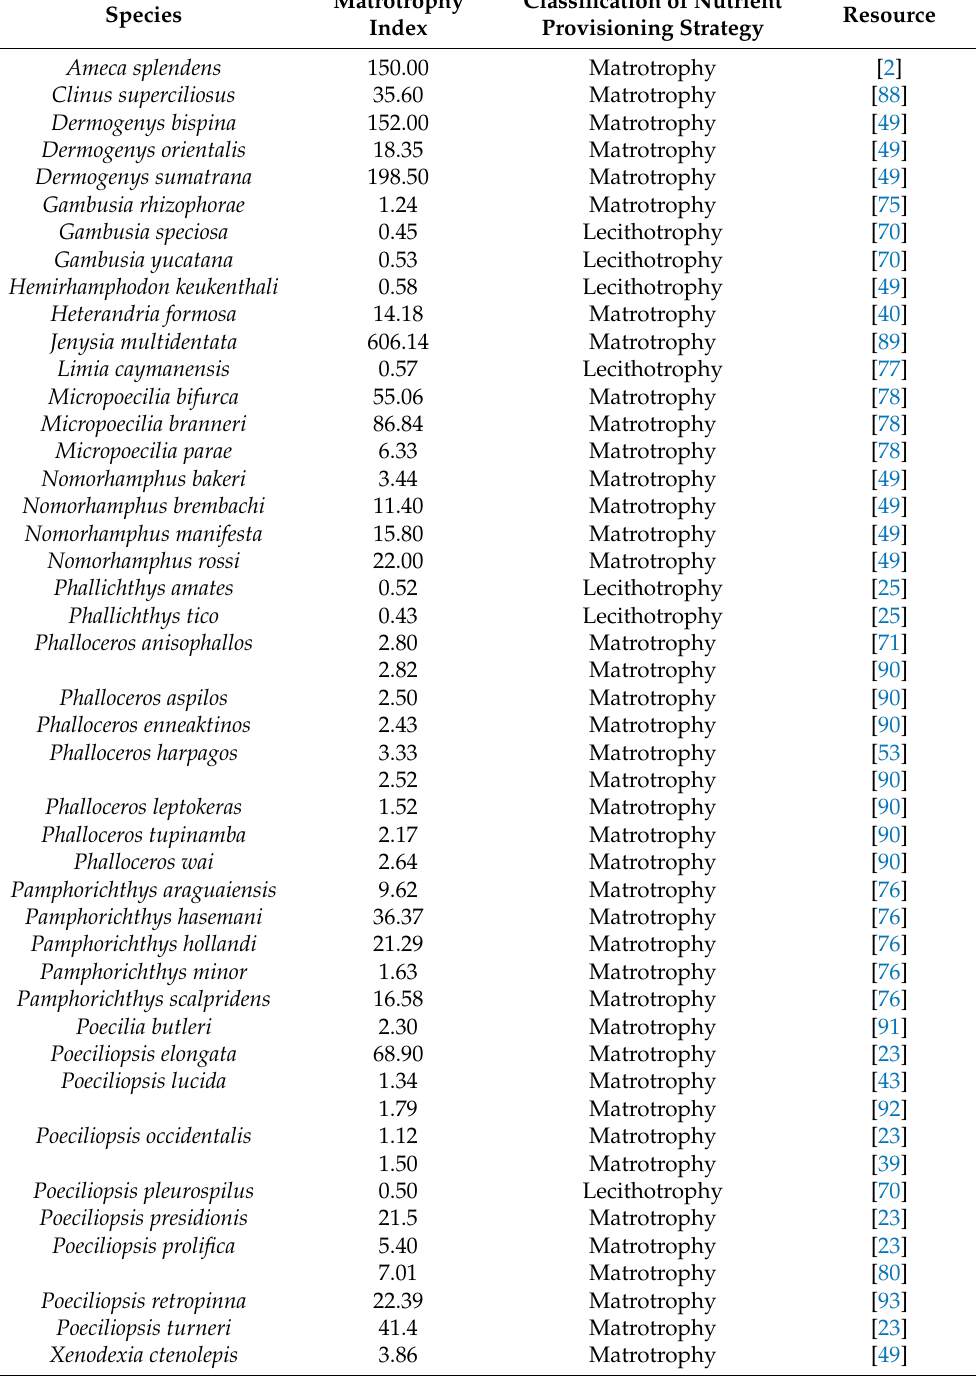
Table 2. A non-exhaustive list of published parentotrophy indices for teleost species with MI < 0.6 or MI > 1.1, including examples from all known matrotrophic teleost families in which MI/PI studies have been conducted; Anablepidae; Clinidae; Goodeidae; Poeciliidae; Zenarchopteridae. All data are presented as in the resource, to 2 decimal